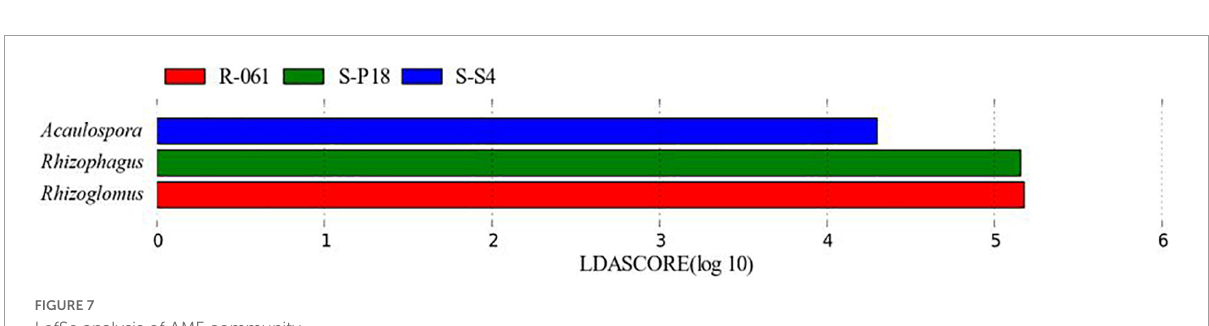
FIGURE7 LefSe analysis of AMF